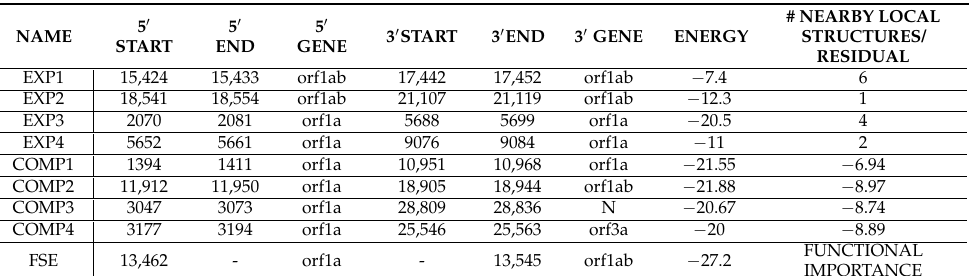
Table 1. List of experimentally reported and computationally predicted long-range RRIs used in the analysis. The first four are reported from a COMRADES experiment, the last four were predicted using IntaRNA, both with and without SHAPE reactivities as a constraint.